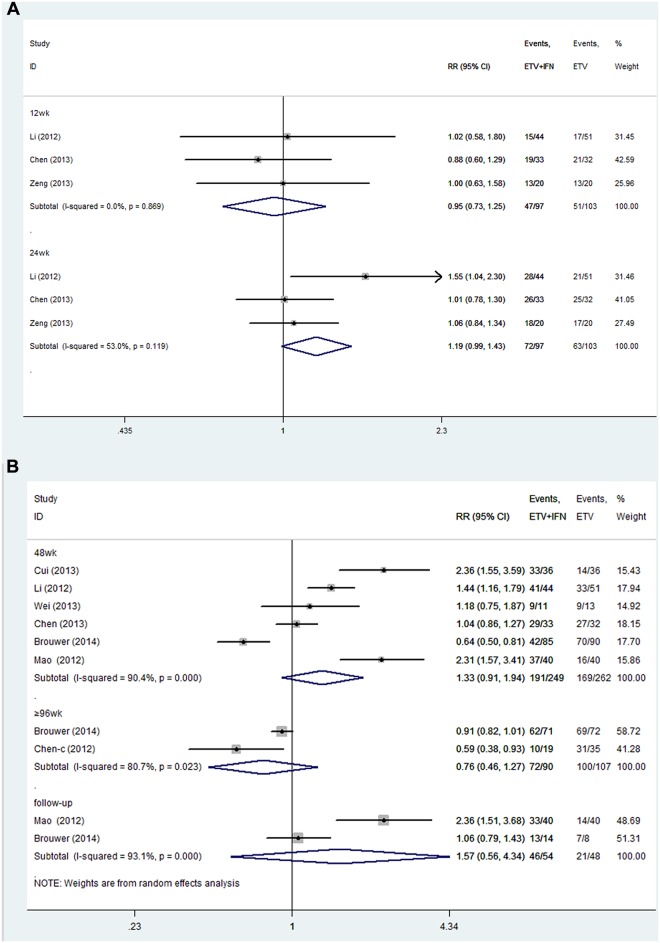
Forest Plot for ALT Normalization when ETV was used as the Control Group.(A) Forest plot for ALT normalization based on a random-effects model. (B) Forest plot for ALT normalization based on a fixed-effects model.